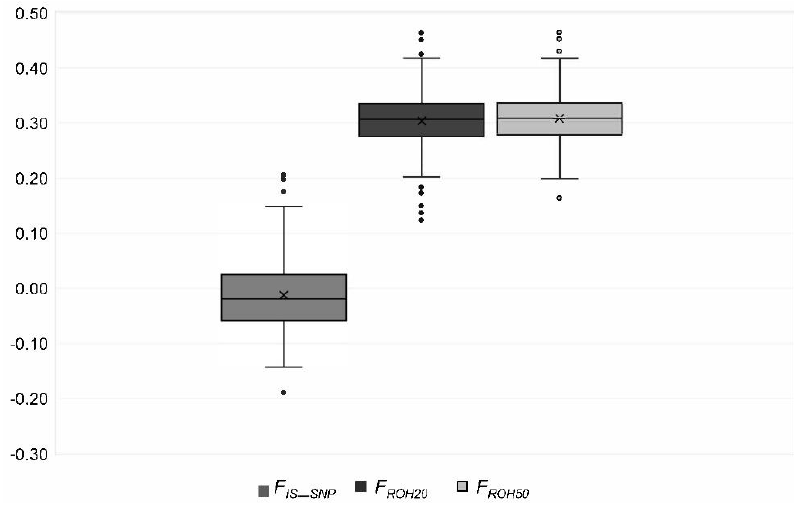
Figure 6. Distribution of the genomic inbreeding coefficients F ROH20 and F ROH50 and the fixation index F IS_SNP in the genotyped Polish Lowland Sheepdogs. Outliers are given with dots. Table 5. Pearson correlation coefficients among inbreeding coefficients. The correlation coefficients with a p -value < 0.0001 between the pedigree inbreeding coefficient F PED , the genomic inbreeding coefficients F ROH for the different lengths of runs of homozygosity (ROHs), and the fixation index F IS_SNP are given.